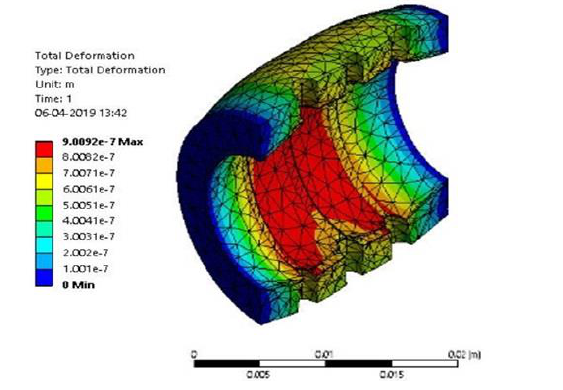
Fig. 15. Deformed bearing 2 under pressure from oil film